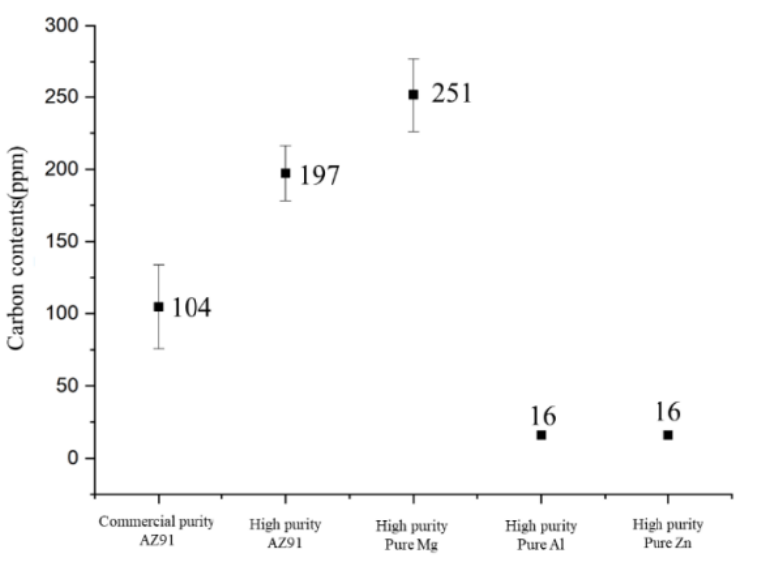
Figure 4. Carbon contents of commercial-purity AZ91, high-purity AZ91 and high-purity pure Mg ingot used for manufacturing high-purity AZ91 alloys.